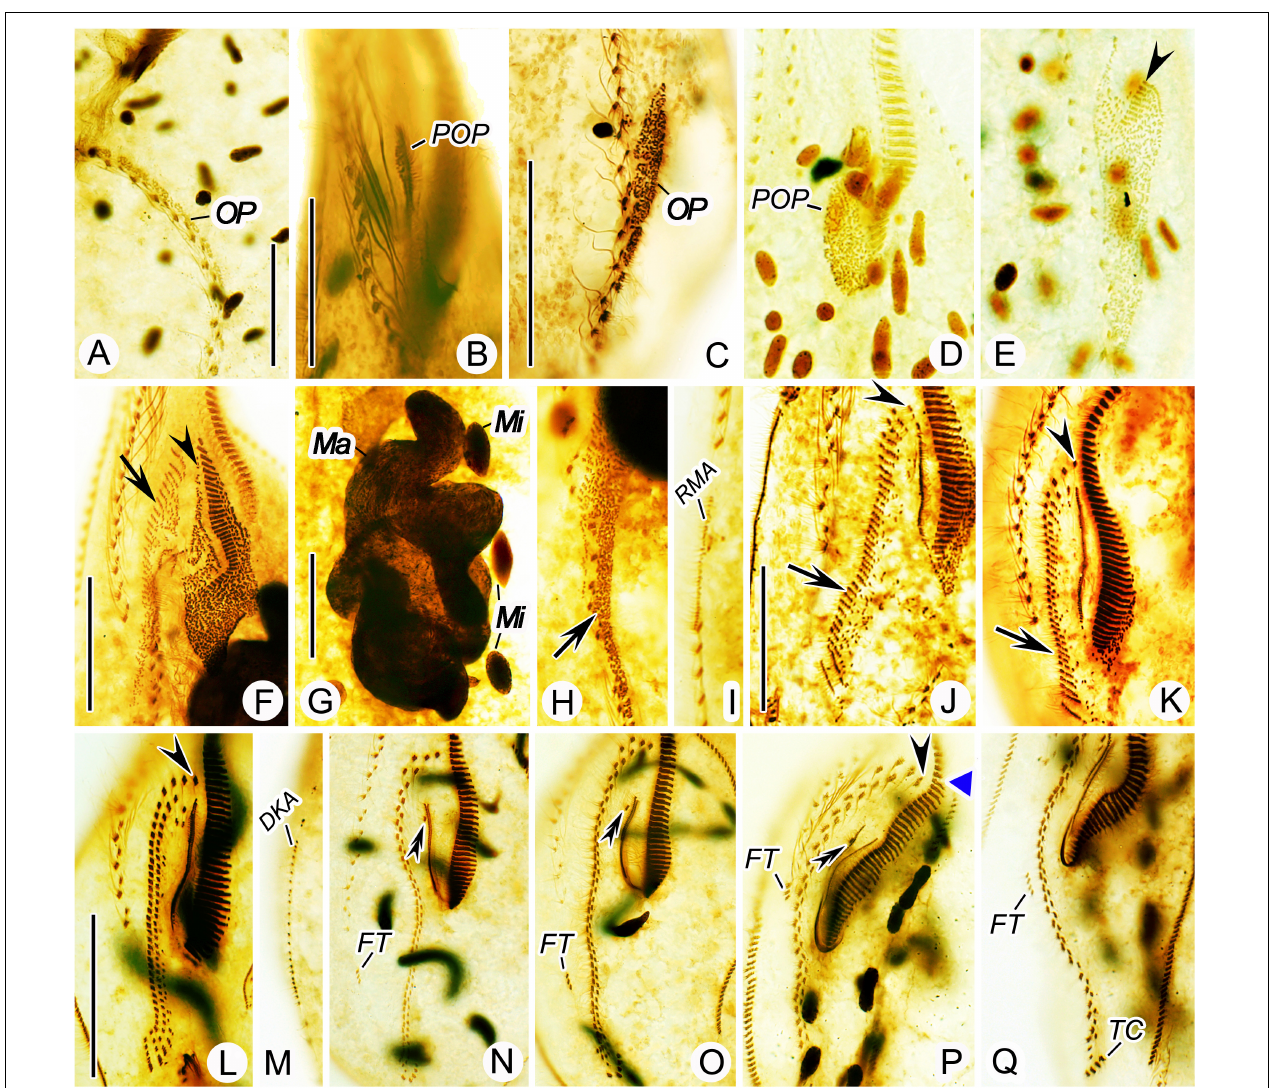
FIGURE 6 | Nothoholosticha luporinii n. sp., various division stages after protargol impregnation. (A) Ventral view of an early divider, showing the opisthe’s oral primordium. (B,C) Ventral view of an early divider, showing the oral primordium in the proter (B) and the opisthe (C) . (D,E) Ventral view of another early divider, arrow marks the proter’s oral primordium (D) and arrowhead denotes the differentiating adoral membranelles from the opisthe’s oral primordium (E) . (F–I) Ventral view of an early mid-divider, showing the undulating membranes anlage (arrowheads) and the frontal-midventral-transverse cirral anlagen (arrows) in (F,H) , the fusing macronuclear nodules and dividing fusiform micronuclei in (G) , the right marginal cirral row anlage in (I) . (J,K) Ventral view of a mid-divider, showing the leftmost frontal cirrus originating from the undulating membranes anlage (arrowheads) and the frontal-midventral-transverse cirral anlagen (arrows) in the proter (J) and the opisthe (K) . (L–Q) Details of different late dividers, showing the leftmost frontal cirrus (arrowheads) in (L,P) , the buccal cirrus (double-arrowheads) in (N–P) , the forming gap in the adoral zone of membranelles (blue triangle) in (P) , the migrating frontoterminal cirri in (N–Q) , the transverse cirri in (Q) , and the dorsal kinety anlage in (M) . DKA, dorsal kinety anlage; FT, frontoterminal cirri; Ma, macronuclear nodules; Mi, micronuclei; OP, opisthe’s oral primordium; POP, proter’s oral primordium; RMA, right marginal cirral row anlage; TC, transverse cirri. Scale bars = 30 µ m (F–K) , 40 µ m (A–E) , and 60 µ m (L–Q)